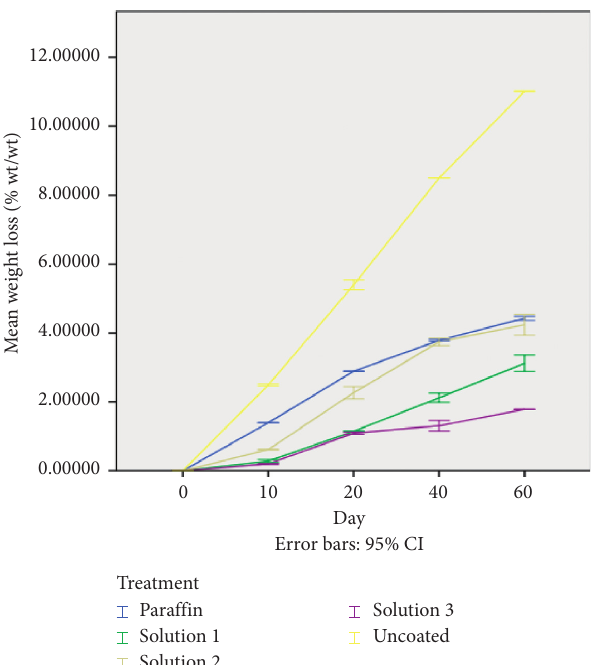
Figure 8: Values (means ± SD) of the weight loss of cheese coated with antimicrobial edible coating solutions—solution 1 (0.250 g/L Delvocid), solution 2 (0.275g/L Delvocid), and solution 3 (0.300 g/ L Delvocid)—compared with cheese coated with commercial coating and uncoated cheese throughout 60d of storage at 10 ° C and 85% relative